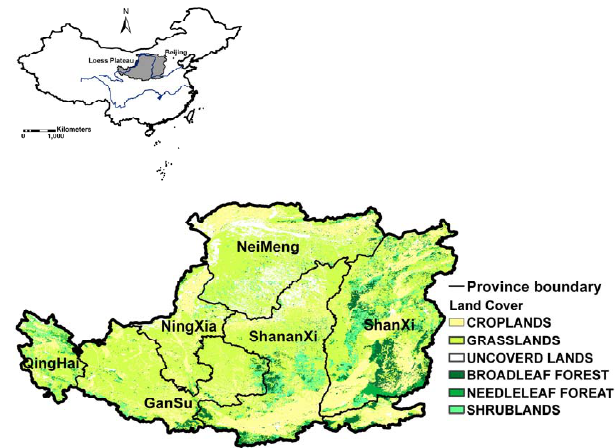
Fig. 1. Location and land cover of the Loess Plateau.